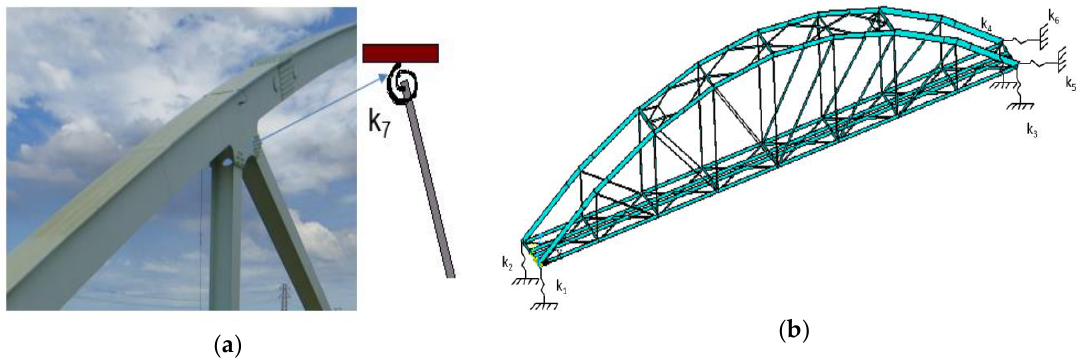
Figure 15. Uncertain structure parameters are selected to update in model: ( a ) The springs at truss joints; ( b ) The springs at bearings.